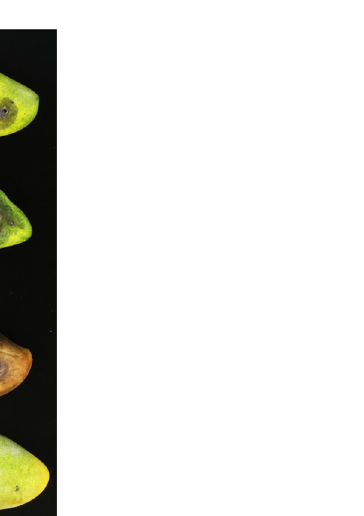
Table 2. Sensitivity of Lasiodiplodia theobromae to different pyraclostrobin resistance phenotypes under different temperature (36h). Phenotype